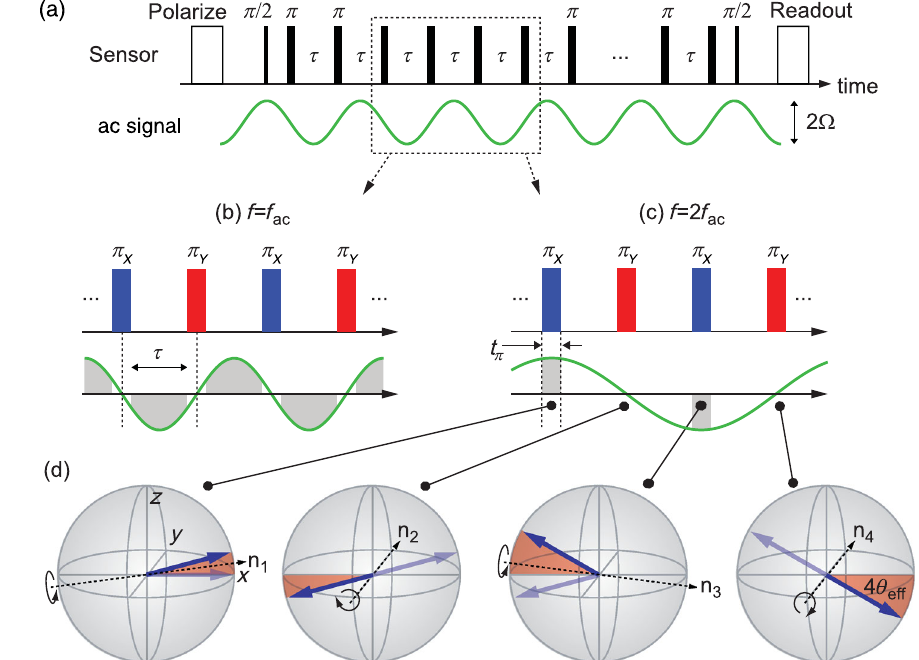
FIG. 1. (a) Generic scheme of multipulse quantum sensing based on Carr-Purcell decoupling. The detection frequency f ¼ 1 = ð 2 τ Þ is adjusted to match the ac signal frequency f . (b,c) Sensor phase accumulation for the XY 4 sequence for the fundamental signal f ¼ f ac and the second harmonic signal f ¼ 2 f . Gray shaded areas show periods where phase accumulation occurs. (d) Bloch vector picture of ac the basic mechanism for phase accumulation at the second harmonic. n 1 … 4 are rotation axes of π pulses, and θ effective field, as explained in the